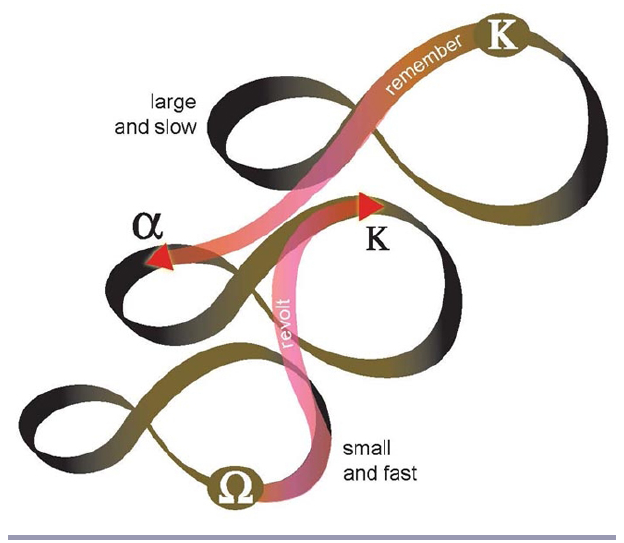
Fig. 1 . A classic representation of a panarchy: a nested set of adaptive cycles. Adapted from Gunderson and Holling